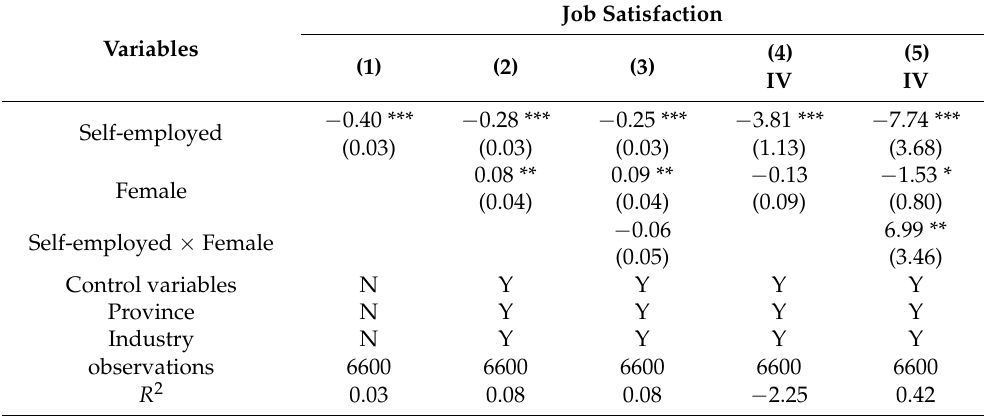
Table 3. OLS and 2SLS regression results of the impact of self-employment on job satisfaction.